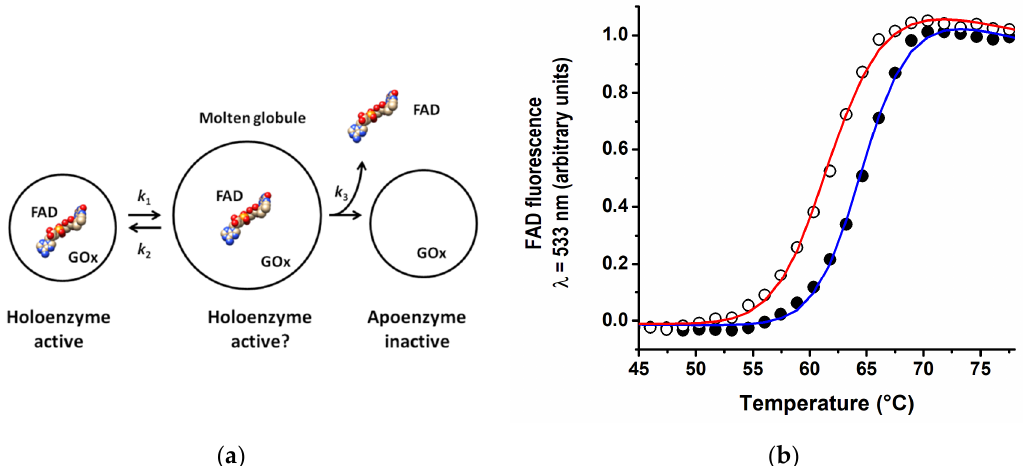
Figure 5. Trehalose prevents the release of FAD during thermal inactivation / unfolding of glucose oxidase (GOx) from Aspergillus niger [198]. ( a ) Thermal inactivation mechanism of GOx [151,189]; ( b ) E ff ect of trehalose on the release of FAD from GOx during thermal inactivation; Trehalose ( ) 0.0, and ( • ) 0.6 M. The data were fitted to the Pace equation [199] by non-linear regression; T 1 / 2 = 61.3 and 64.3 °C in the absence and presence of 0.6 M trehalose, respectively. Adapted with permission from